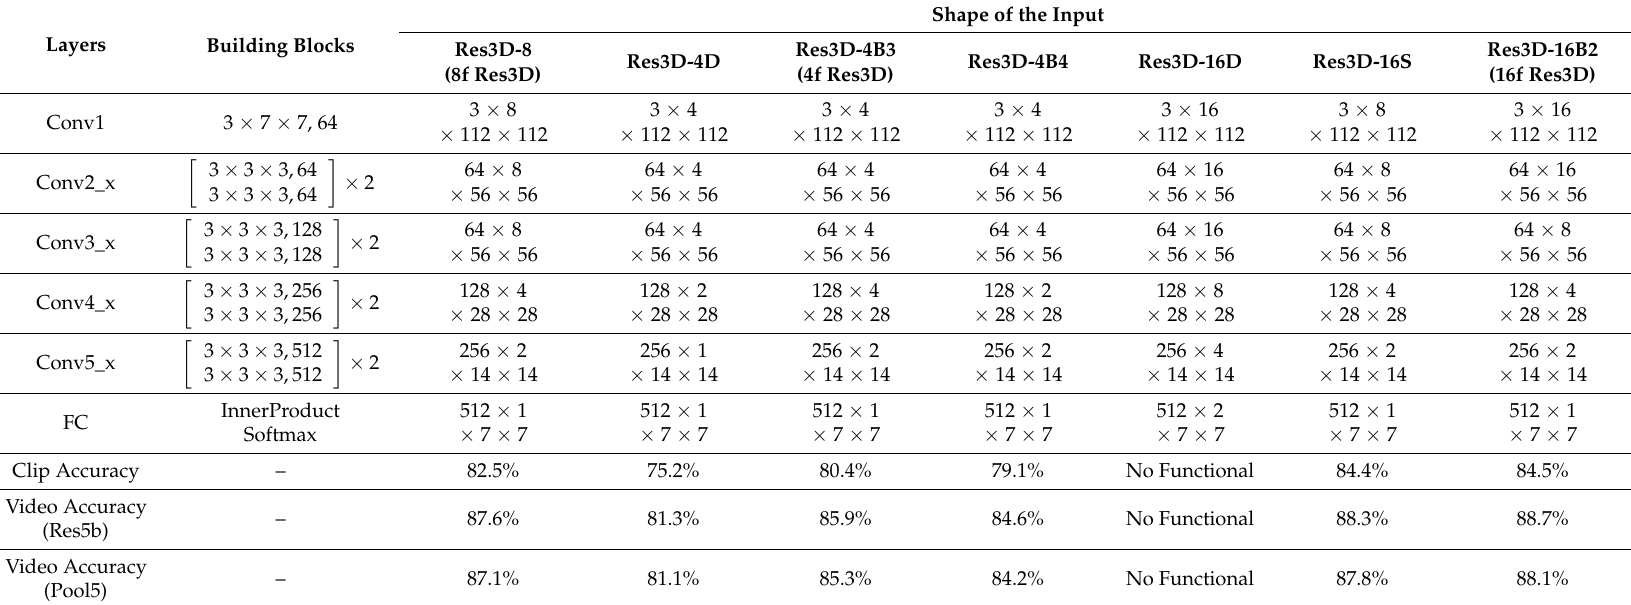
Table 1. Res3D architectures and the recognition results on UCF101